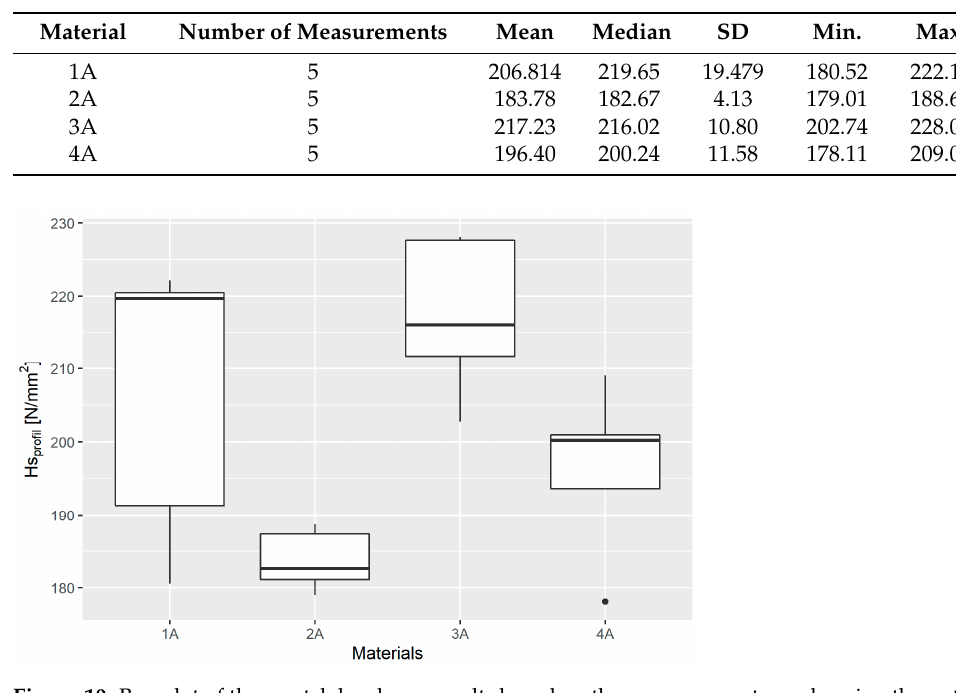
Figure 10. Box plot of the scratch hardness results based on the measurements made using the optical profilometer ( Hs profil ) in individual material groups.